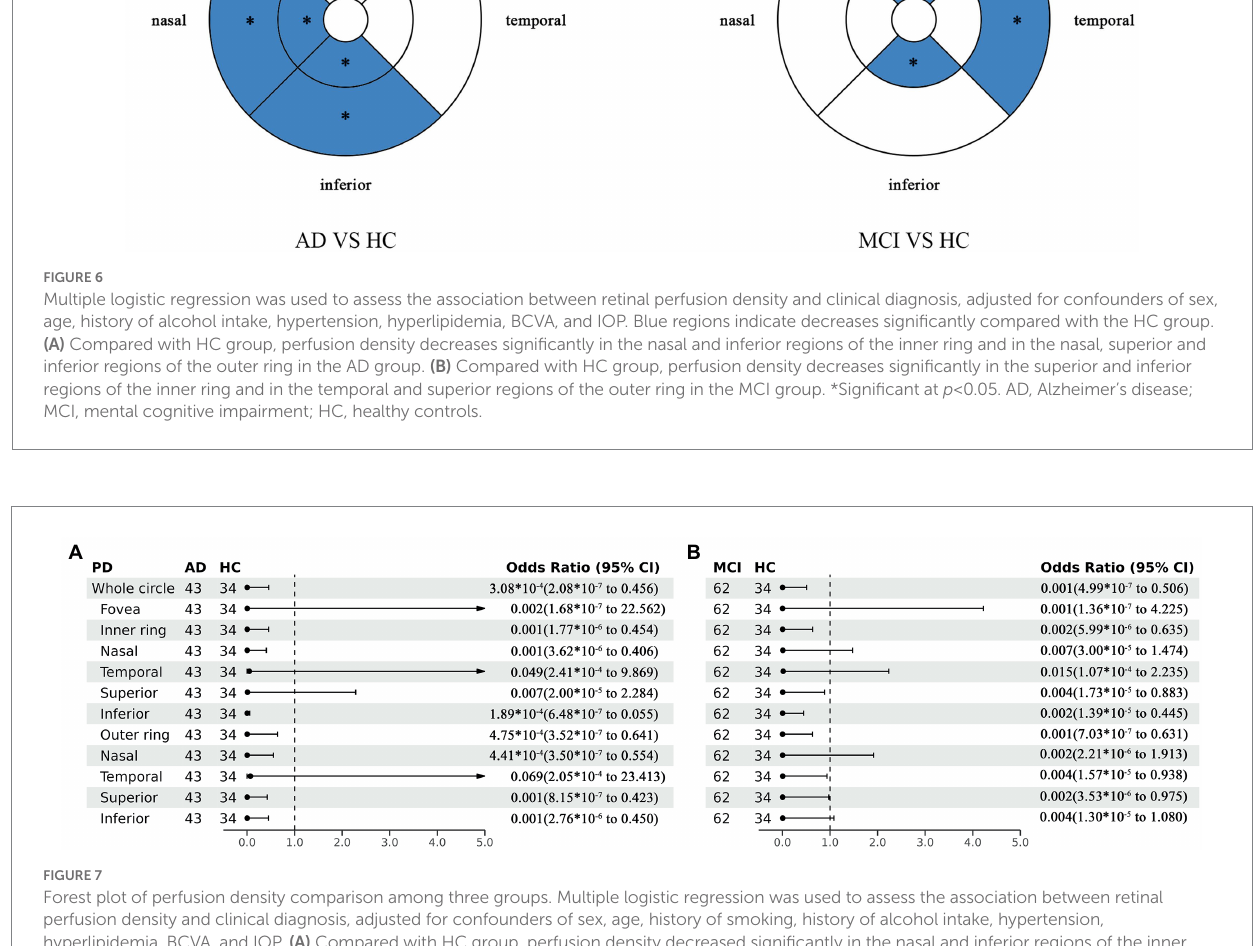
flow indicators and A β , p-Tau protein.